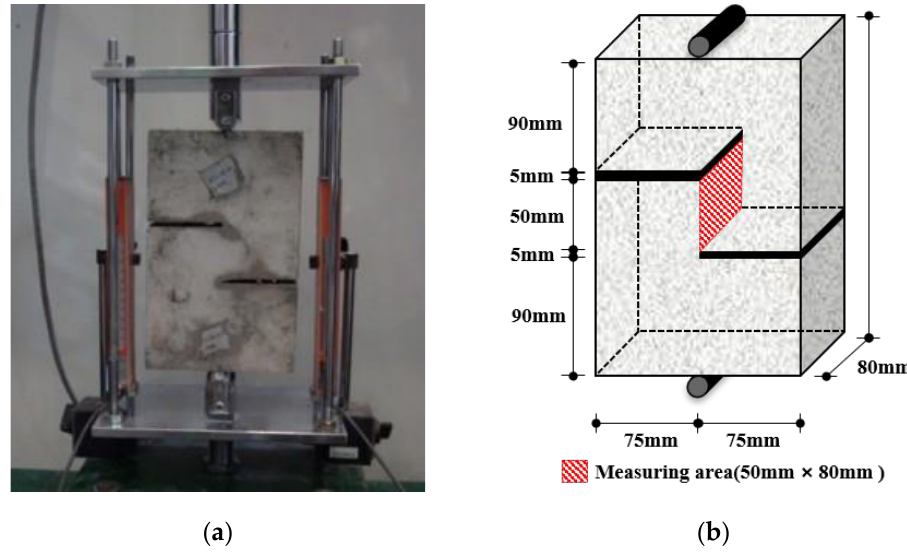
Figure 5. Direct shear test: ( a ) Test setup; ( b ) Specimen geometry.